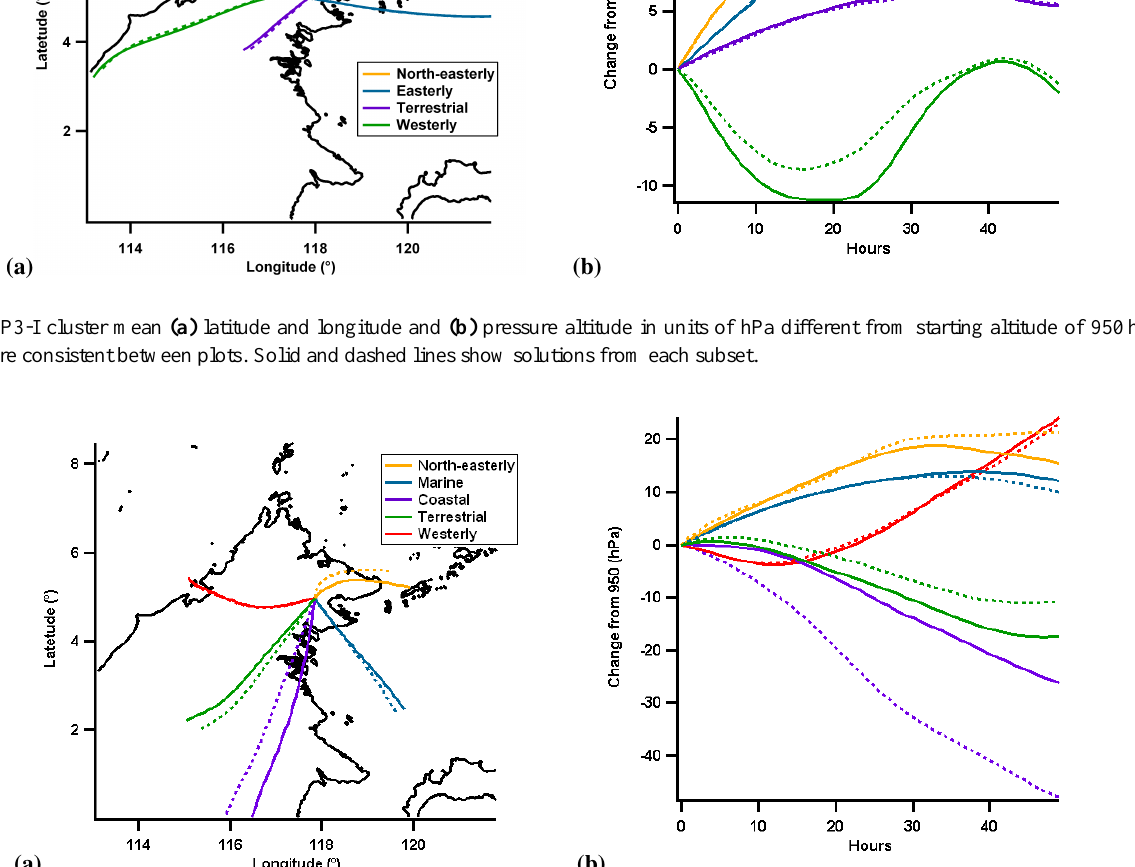
Fig. 5. OP3-III cluster mean (a) latitude and longitude and (b) pressure altitude in units of hPa different from starting altitude of 950 hPa. Colours are consistent between plots. Solid and dashed lines show solutions from each subset.